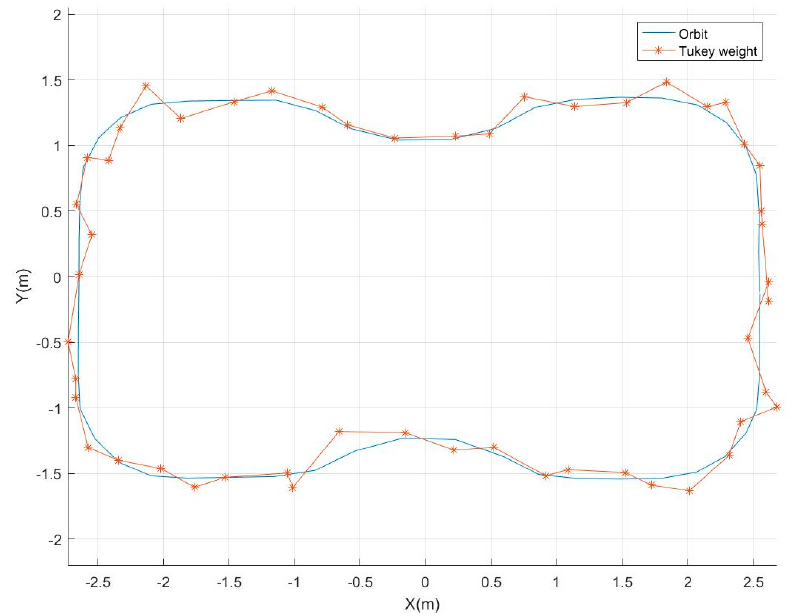
Figure 15. The vehicle trajectory calculated by the Tukey weight method.